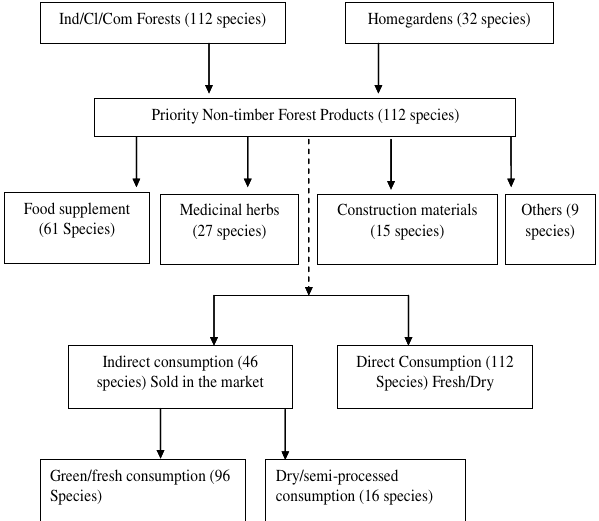
Fig. 4. Production and consumption pattern of Priority NTFPs of Ziro Valley. Ind = individual, Cl = clan, Com = community,